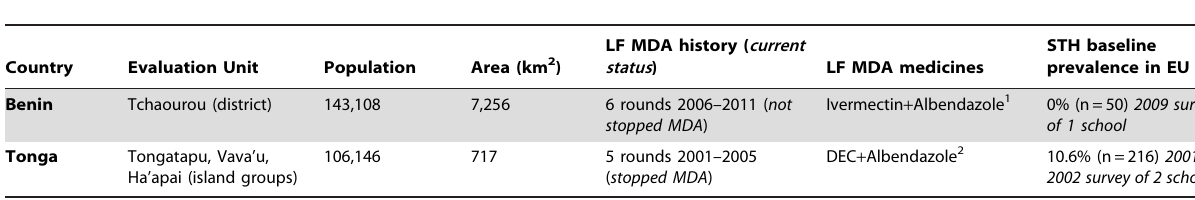
Table 2. Evaluation unit characteristics for LF and STH